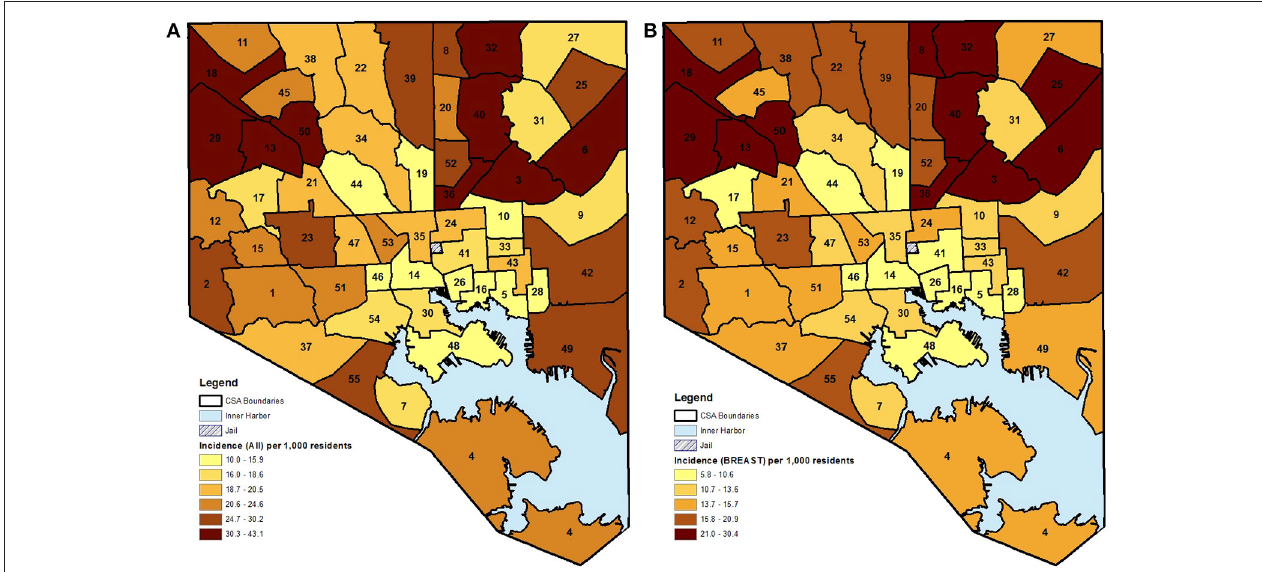
FIGURE 1 | (A,B) CSA distribution shaded by quintile of female cancer incidence (all and breast) in Baltimore City, MD per 1,000 female residents aged 21–74 years, 2000–2010. (See Supplemental Table 1 for key to CSA ID numbers).